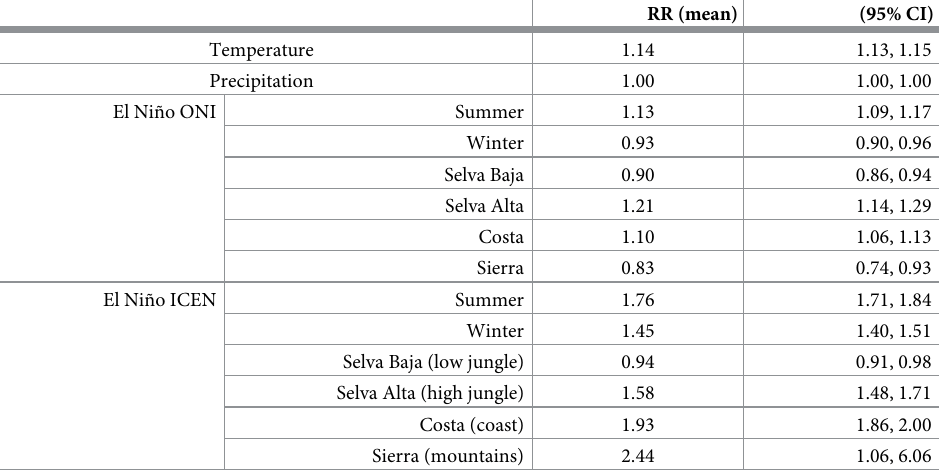
Table 2. Results from regression models, presented for each exposure of interest. Temperature and precipitation were fit in the same model, thus each was adjusted for the other; no adjustments were made in either El Nin`o